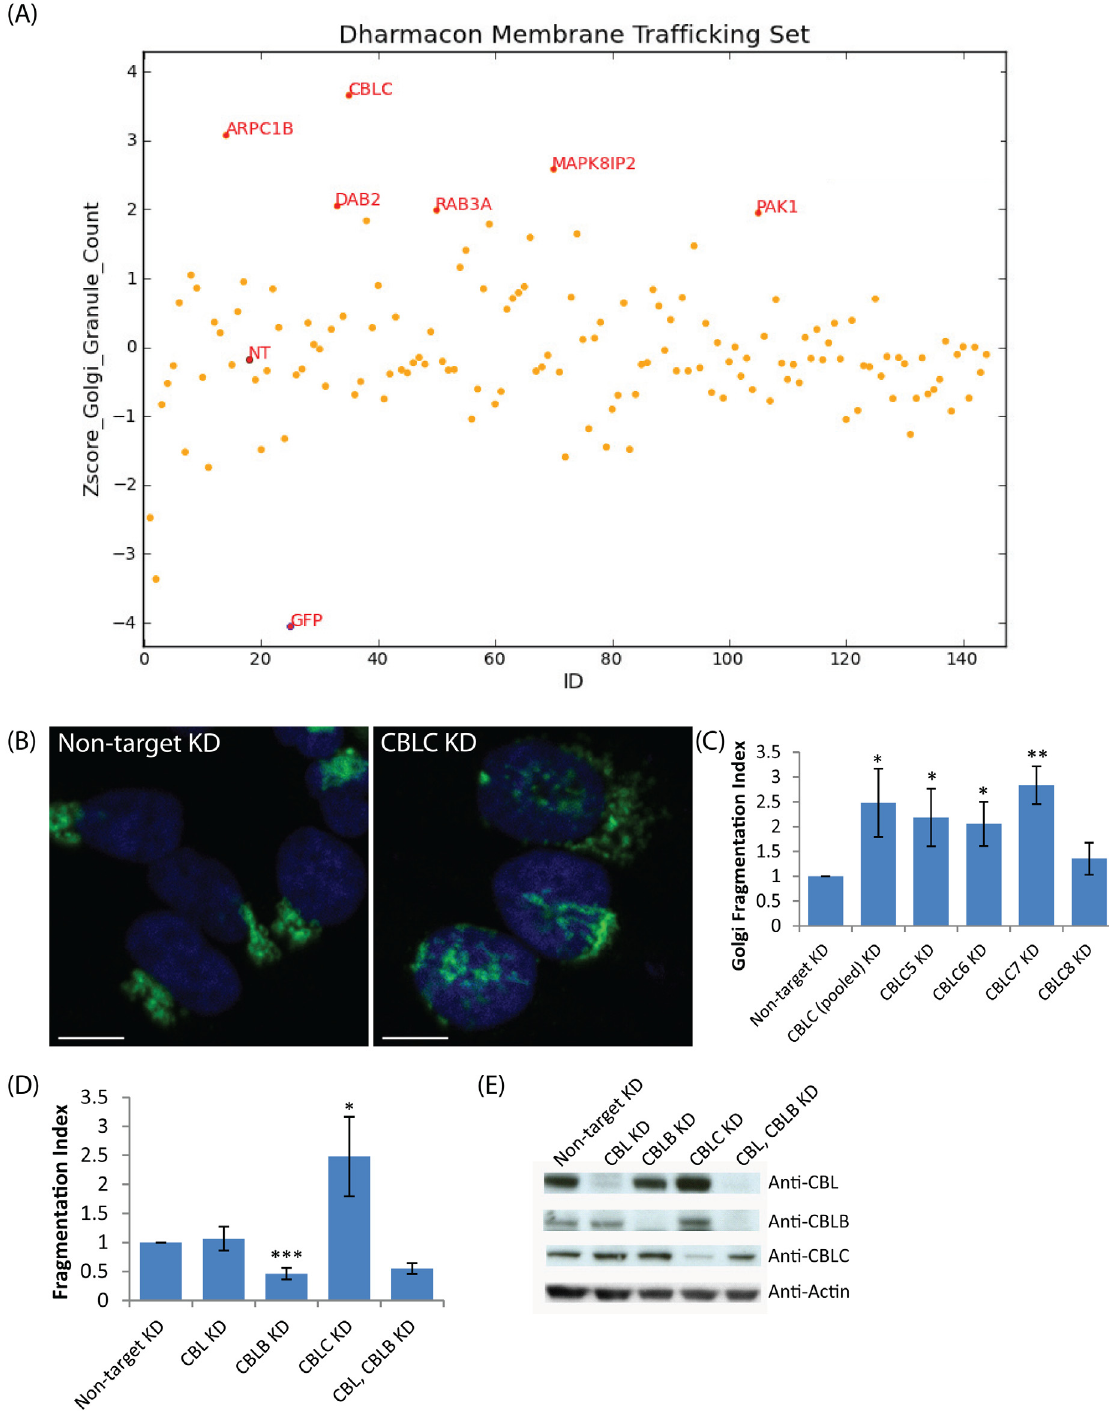
Fig 1. A targeted RNAi screen for Golgi organization identifies CBLC as a Golgi regulator. (A) Plot of granule count of MannII-GFP signal per cell (Z- score) for 120 genes screened. NT: Nontargeting siRNA (B, C) Golgi fragmentation in wild-type HeLa with individual siRNAs. (B) Giantin (green) and Hoechst (blue) staining HeLa cells, CBLC depletion with pool of siRNA. (C) Golgi Fragmentation Index with pool and single siRNAs, measured in triplicates on at least 800 cells per condition. Error bars show SD statistical significance (p) measured by unpaired Student ’ s t-test. ( * ) represents p < 0.05, ( ** ) represents p < 0.01 and ( *** ) represents p < 0.001 relative to non-target siRNA transfected cells. Scale bar = 10 μ m. (D) Golgi fragmentation Index after targeting Cbl family members, siRNA pools (E) Western blot analysis of CBL, CBLB and CBLC depleted cells.